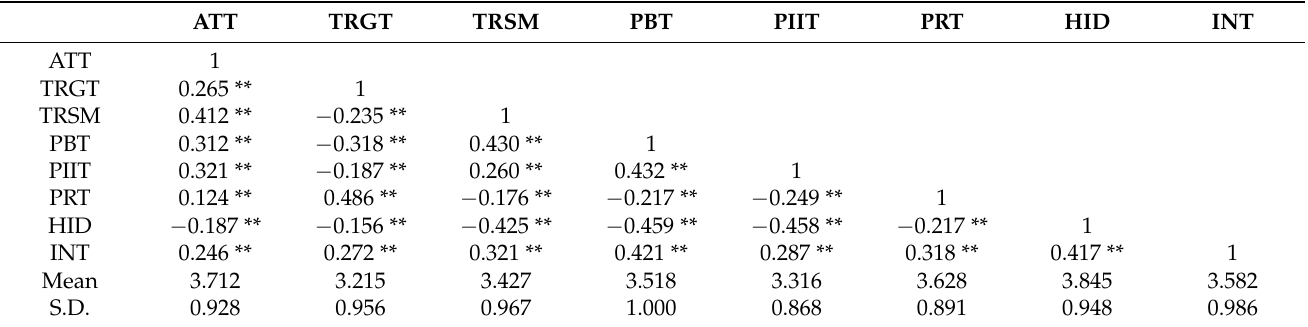
Table 1. Cronbach’s alpha value and Pearson correlation.